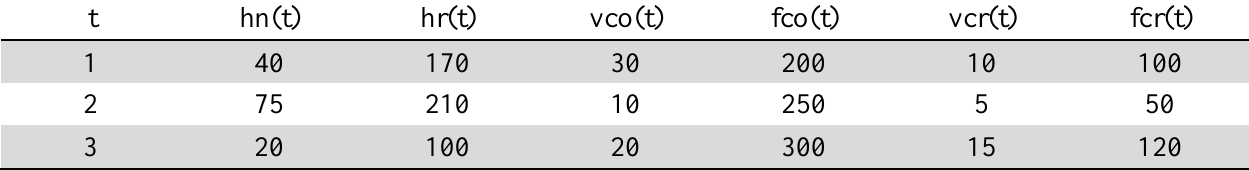
Assumption for holding cost and fixed cost of new and remanufactured products